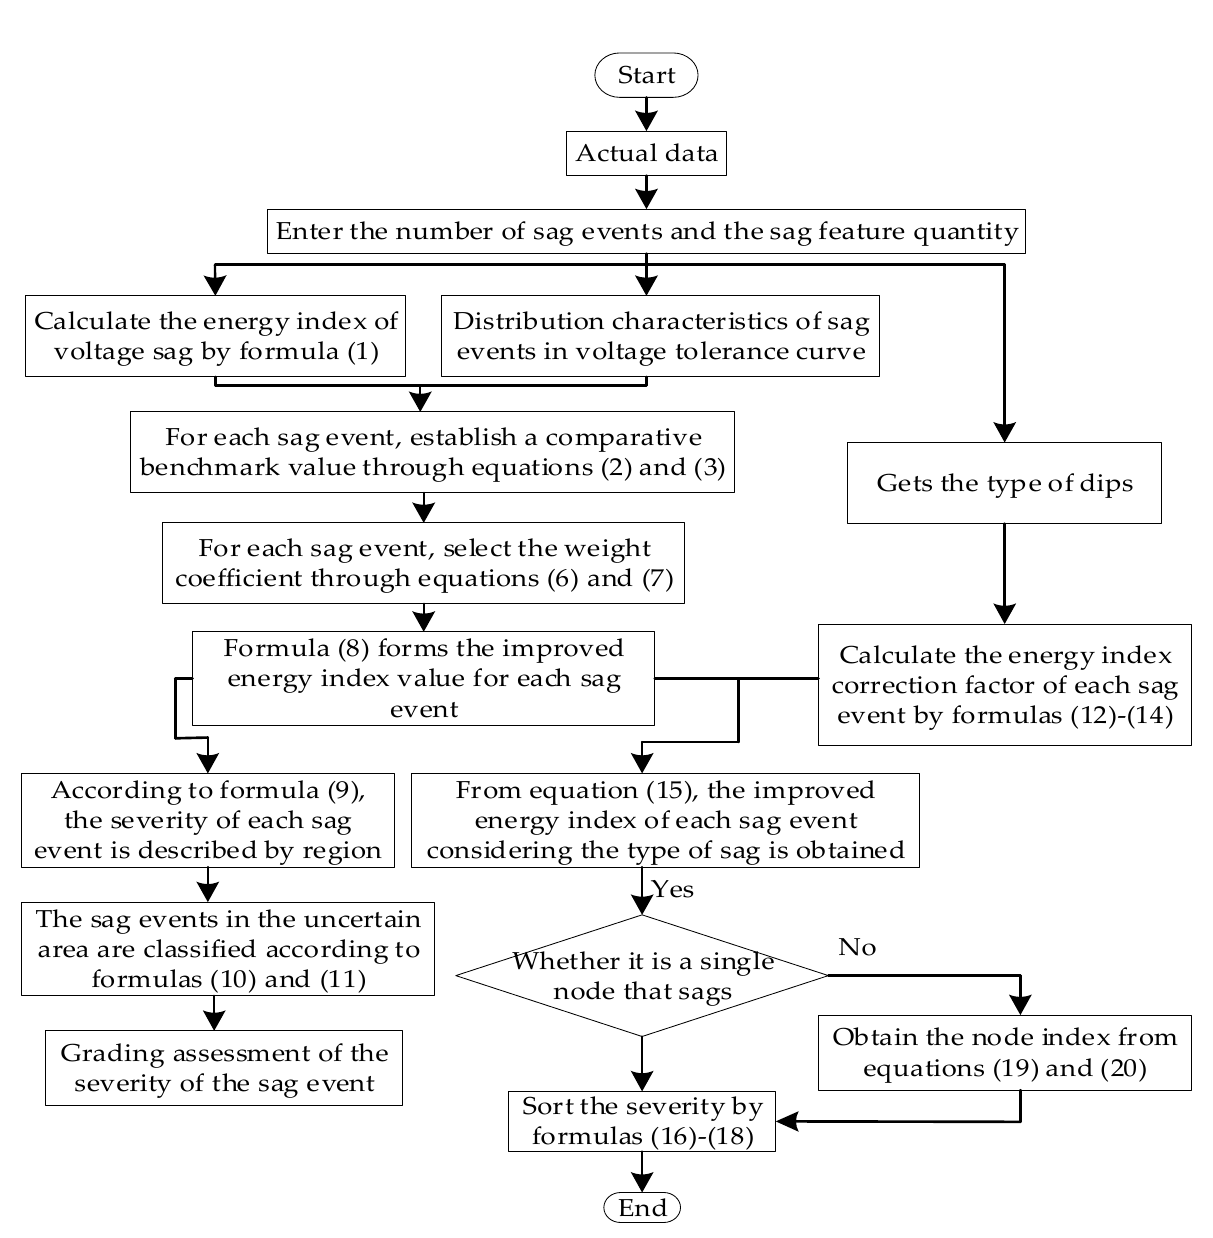
Figure 6. Evaluation process of voltage sag based on improved energy index.